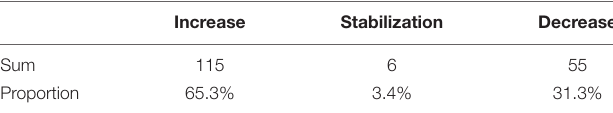
TABLE 3 | Results of reported trends of the Asiatic Black Bear population in the past 10 years. Increase